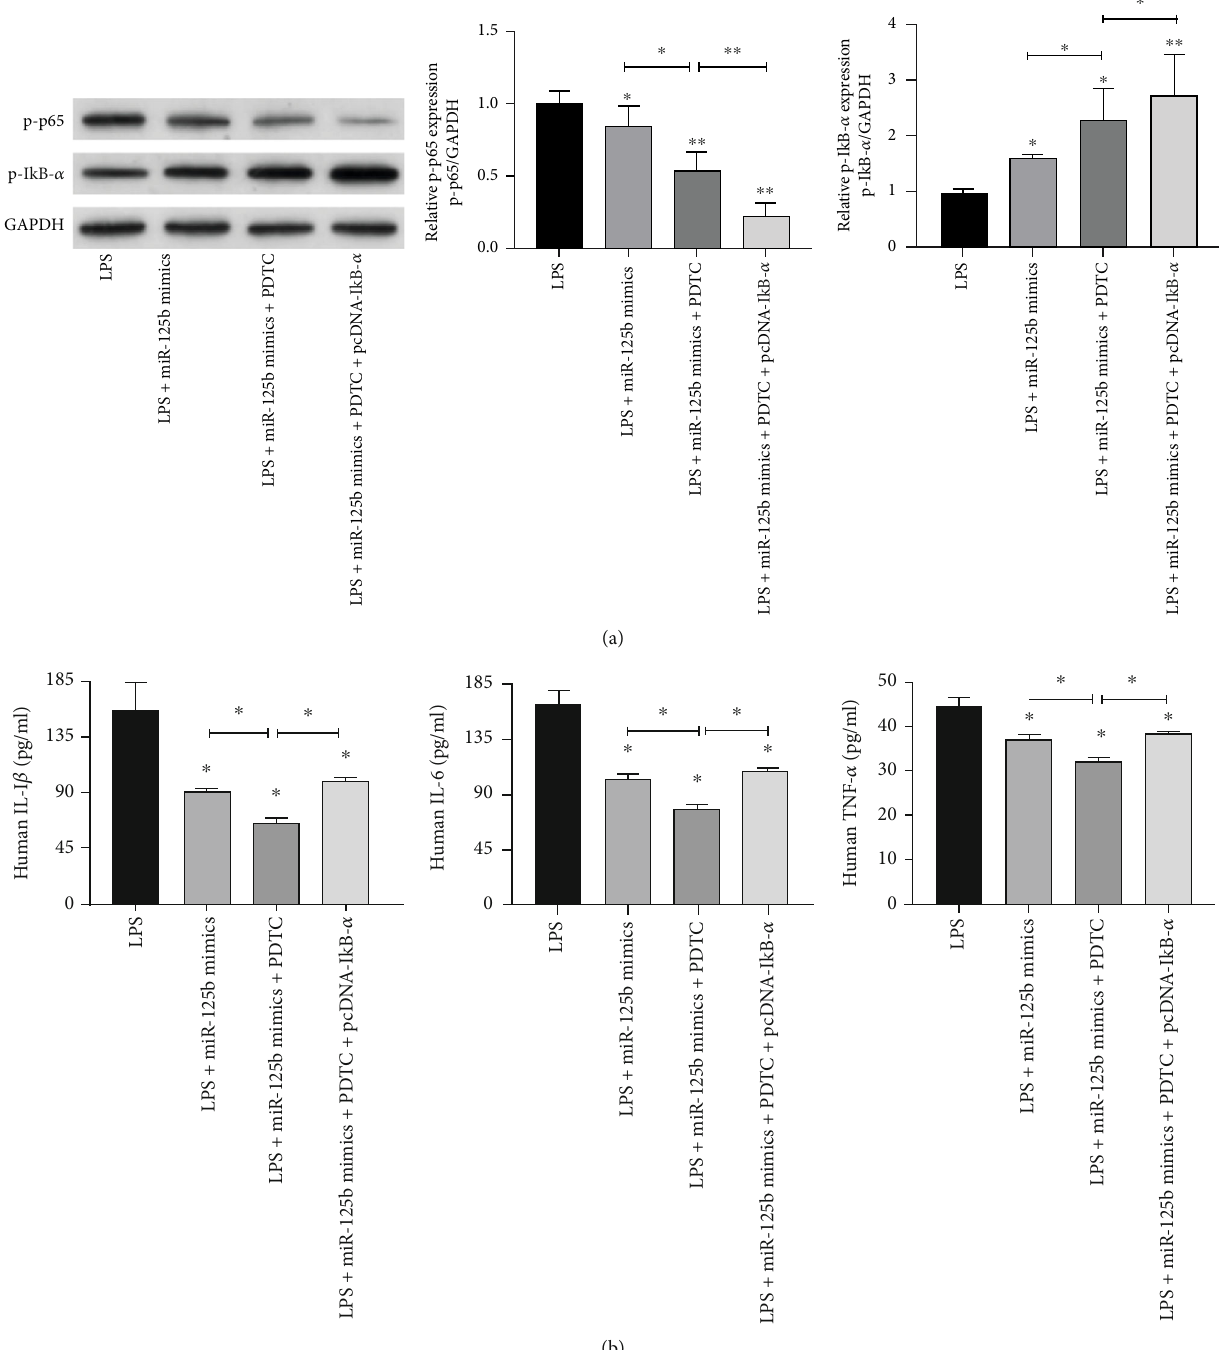
Figure 4: miR-125b suppresses NF- κ B activation through CK2 in LPS-treated MH7A cells. MH7A cells were transfected with miR-125b mimics or cotransfected with miR-125b and pcDNA-IkB- α and then treated with LPS or PDTC. (a) The protein level of p-p65 and p- IkB- α was evaluated via western blot. (b) The cytokine protein levels including TNF- α , IL-1 β , and IL-6 in the cellular supernatant were measured by using ELISA assay. N = 3 , ∗ p < 0 : 05 , ∗∗ p < 0 : 01 , and ∗∗∗ p < 0 : 001